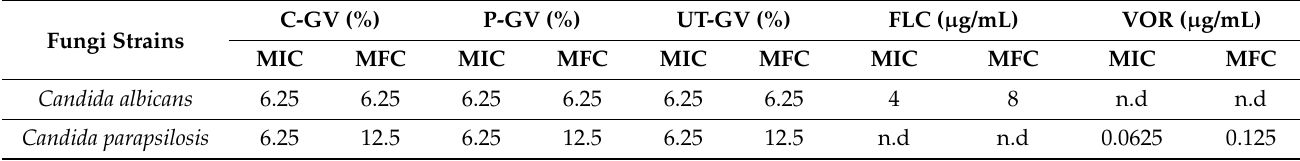
Table 8. Antifungal activity of C-GV, P-GV, and UT-GV against Candida